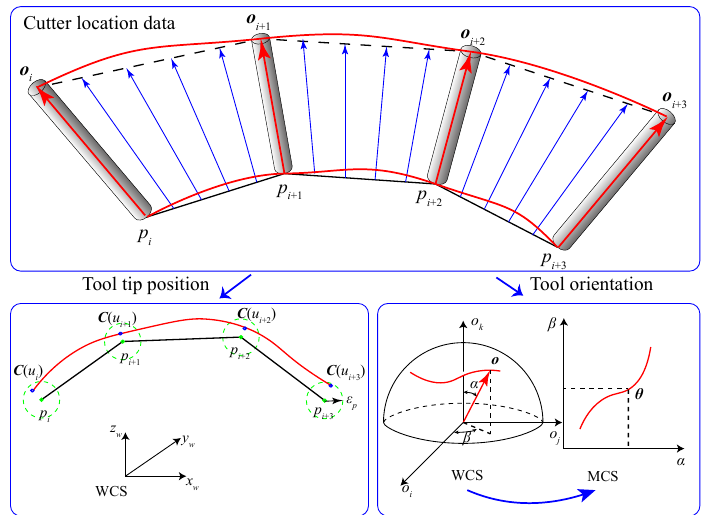
Figure 1. Overview of double B-spline